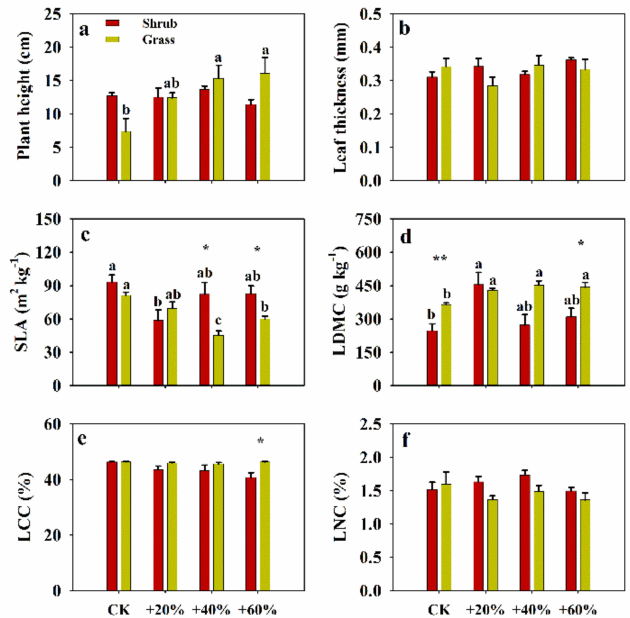
Figure 1. Effects of experimentally-increased precipitation on functional traits of Stipa glareosa in the Inner Mongolian desert steppe. ( a ) Plant height, ( b ) leaf thickness, ( c ) specific leaf area (SLA), ( d ) leaf dry matter content (LDMC), ( e ) leaf carbon content (LCC) and ( f ) leaf nitrogen content (LNC). Different lower-case letters indicate significant differences ( p < 0.05) between treatments for the same vegetation type. Asterisks represent significant differences between different vegetation types, *: p < 0.05, **: p <